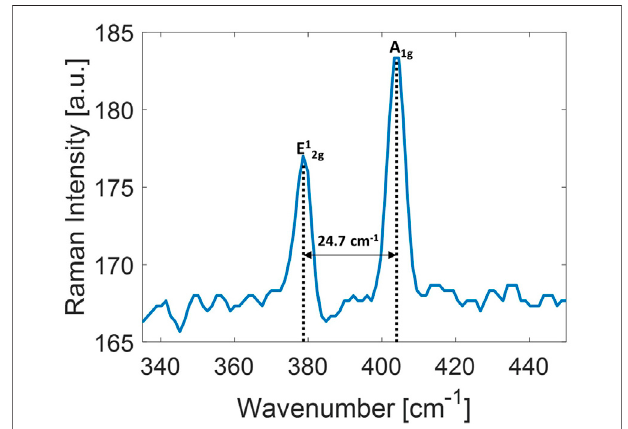
FIGURE 3 | Raman spectrum of 2D-MoS 2 dispersion employed in this study. The distance between the two main peaks of MoS 2 modes is also